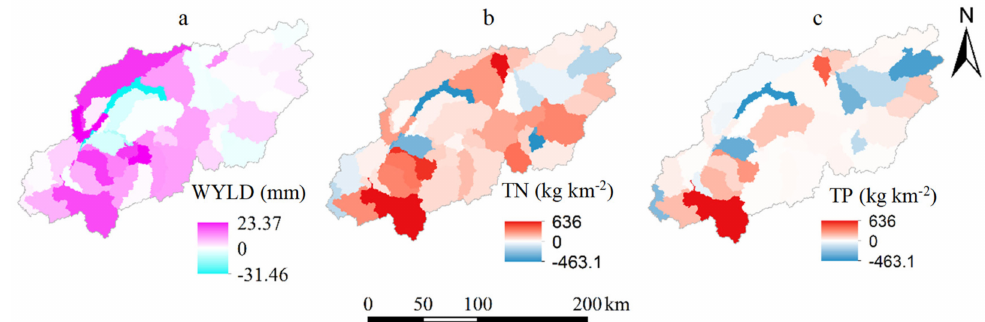
Figure 8. The spatial distribution of the water yield (WYLD), total nitrogen (TN) and total phosphorus (TP) yield changes in 2004–2015 based on the “fixing-changing” method. ( a ) WYLD changes in 2004–2015; ( b ) TN changes in 2004 and2015; ( c ) TP changes in 2004 and